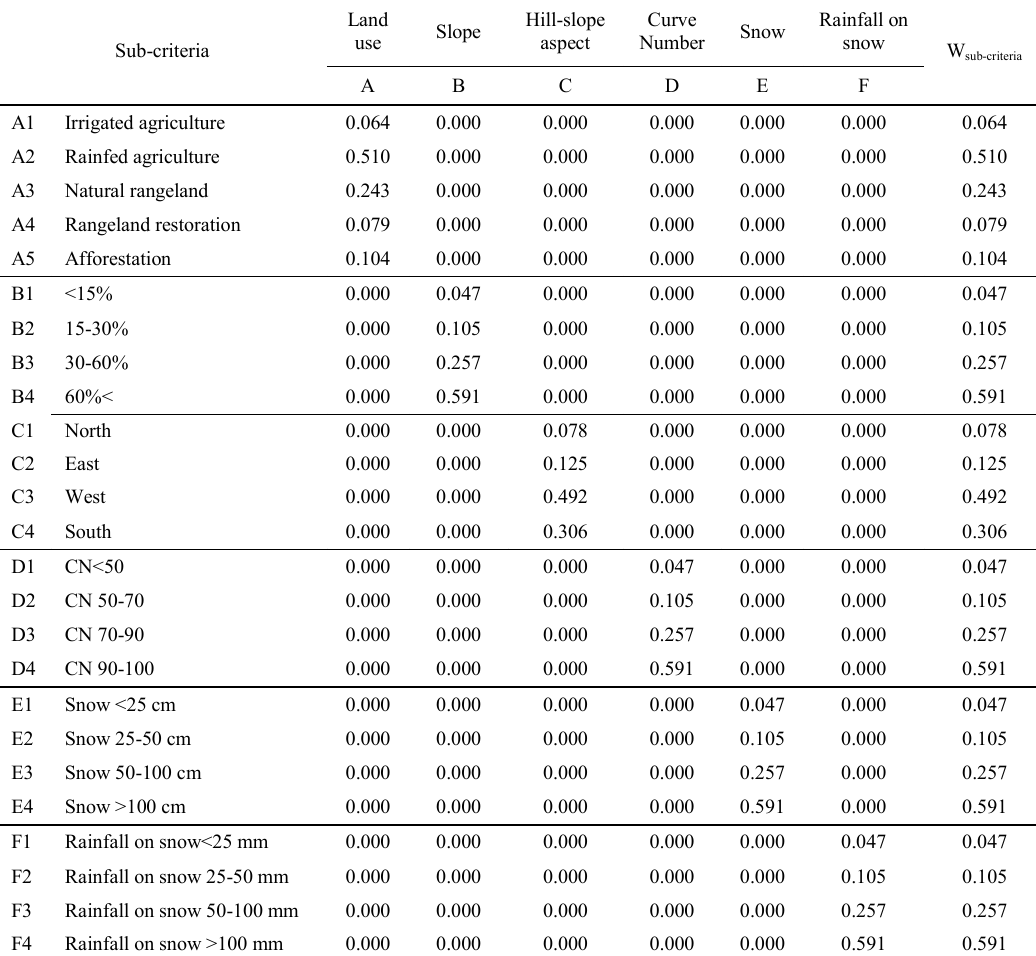
Table 7: The W matrix and relative importance of the sub-criteria (W 32